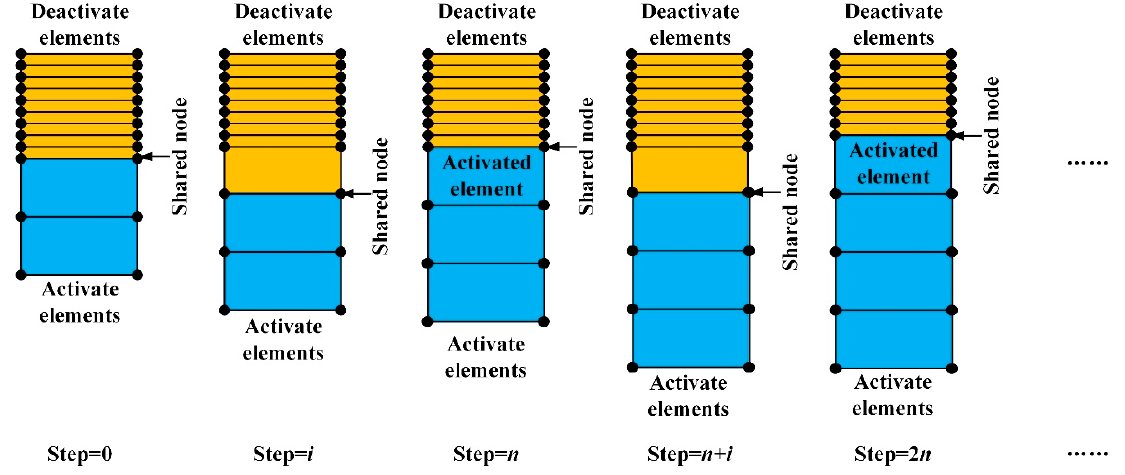
Figure 4. Schematic diagram of activate elements and deactivate